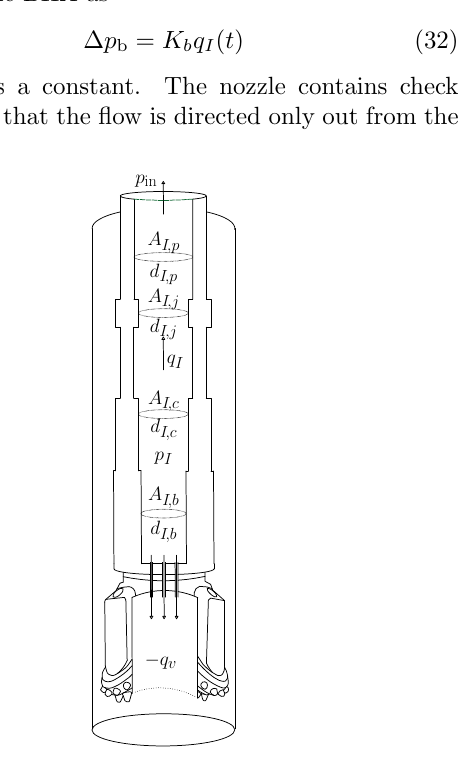
Figure 2: The inner DS control volume. The dynamics is lumped to one segment.